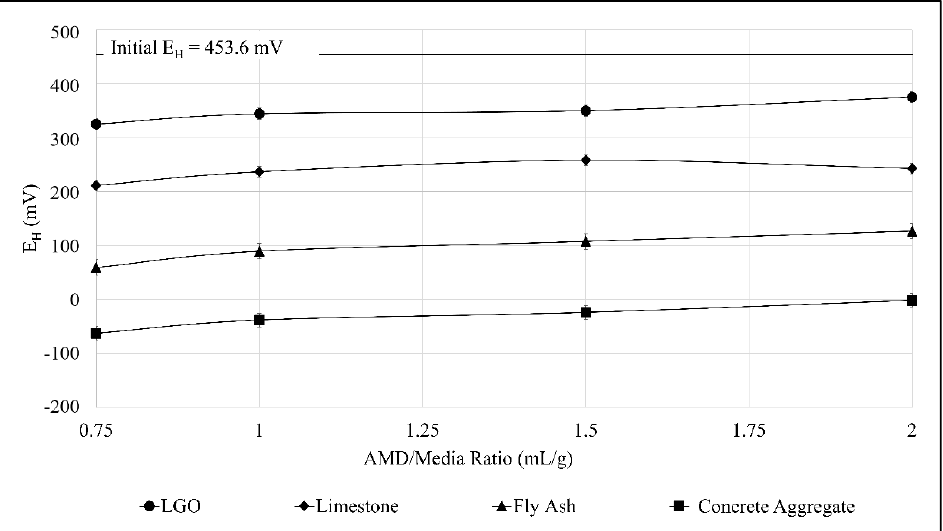
Figure 4. Effect of AMD/Media ratio on E H after 1-h mixing. Figure 4. E ff ect of AMD / Media ratio on E